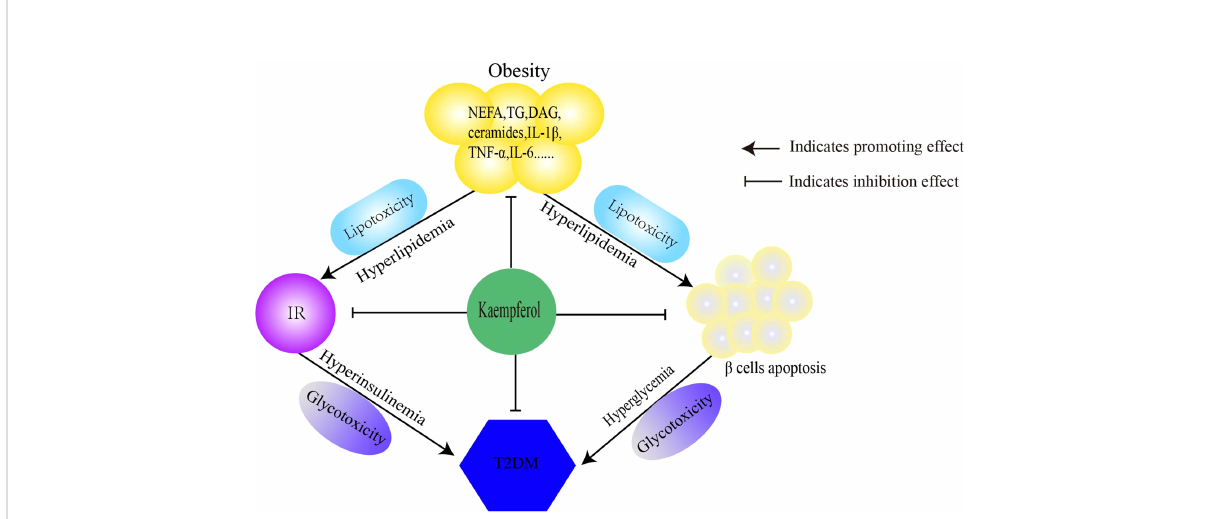
FIGURE 1 Mechanism of kaempferol antidiabetes. Kaempferol prevens the pathological progress of obesity-insulin resistance- b Cells apoptosis-diabetes. IR, insulin resistance; T2DM, type 2 diabetes